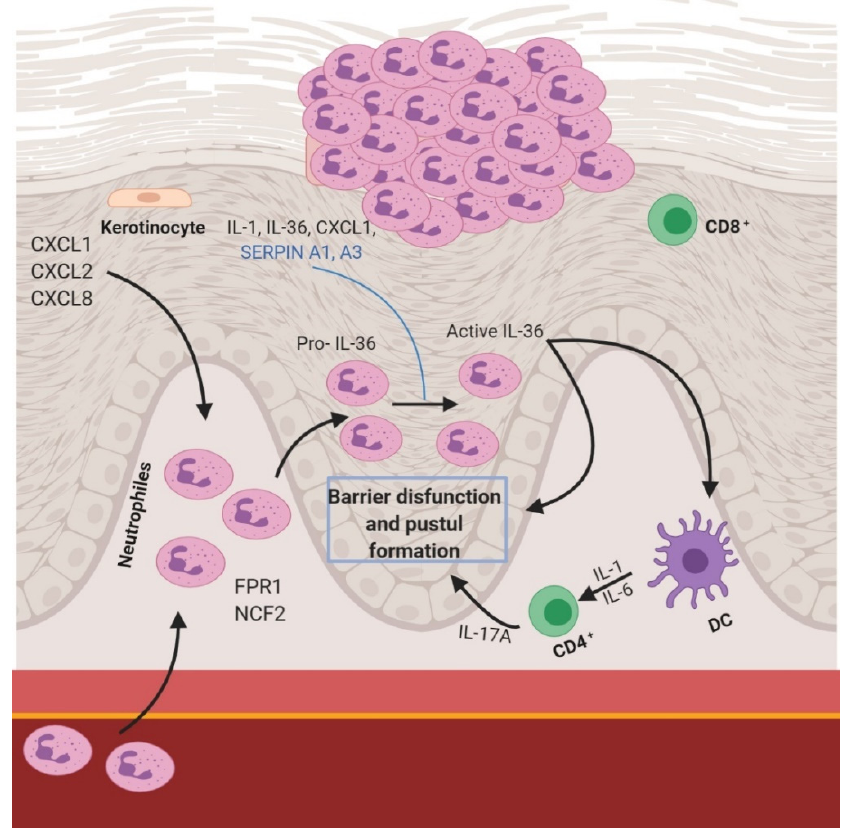
Figure 2. Pathophysiology in pustular psoriasis.